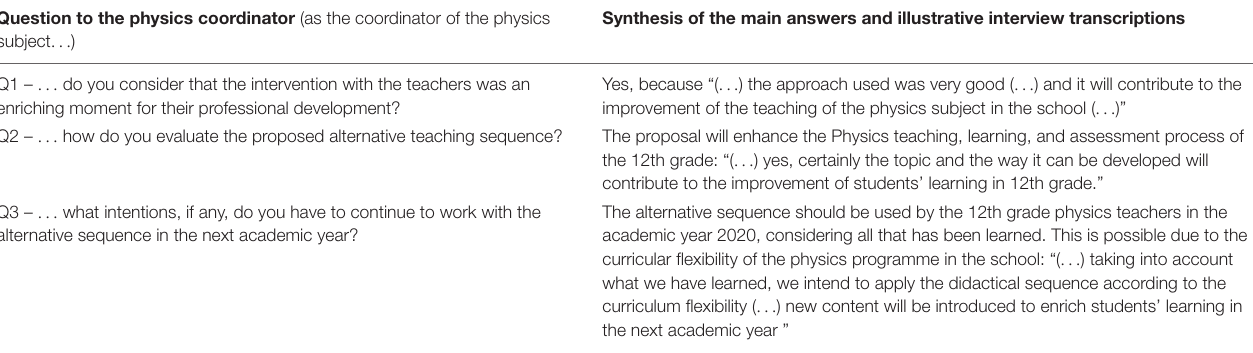
TABLE 4 | Main questions asked and answers provided by the physics coordinator, with examples of the interviewee’s speech. Question to the physics coordinator (as the coordinator of the physics subject ...